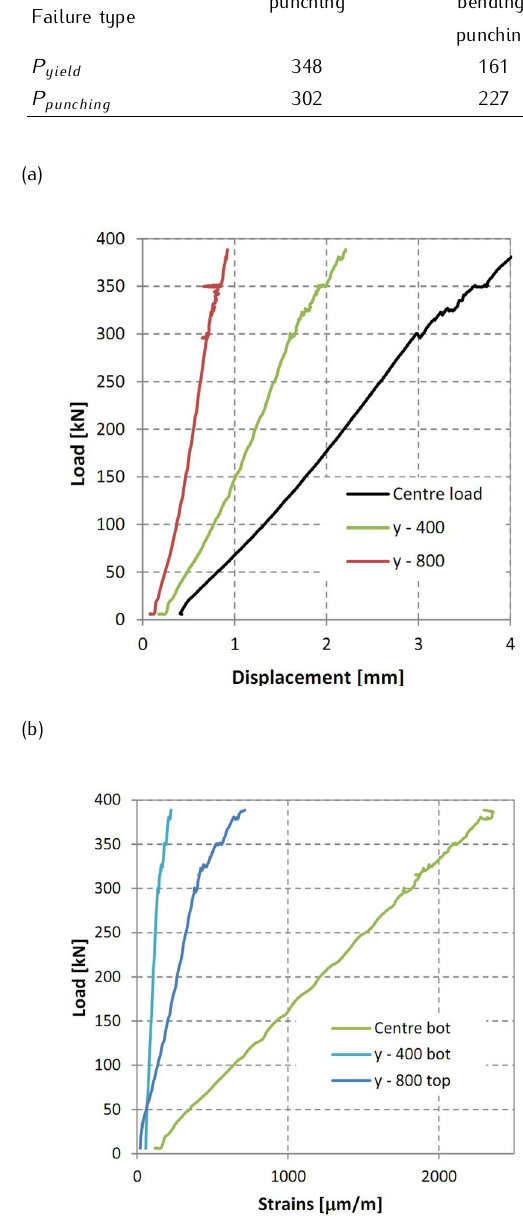
Figure 9. Centre load, (a) Displacements, (b)